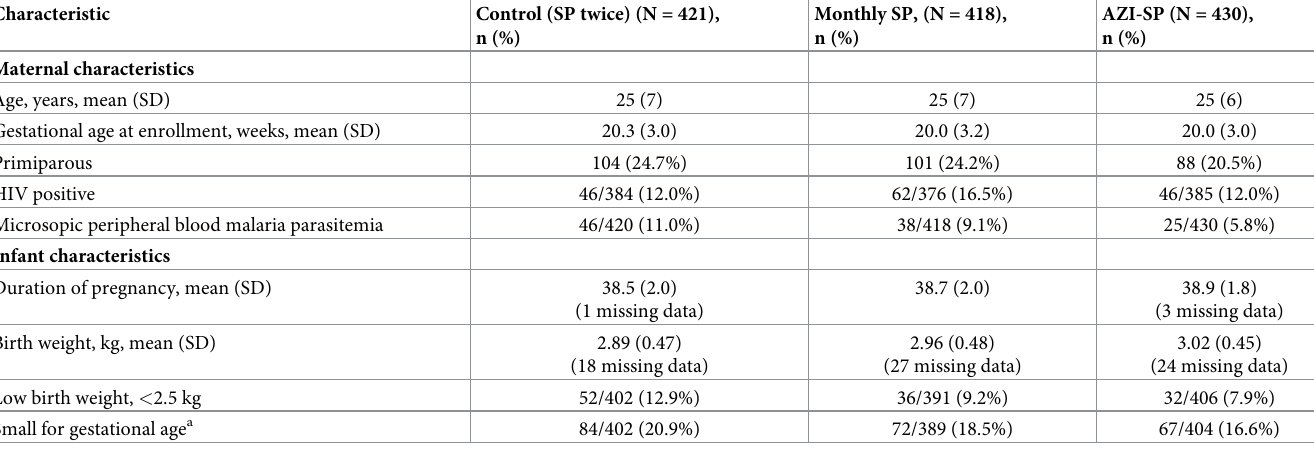
Table 1. Baseline characteristics of the participating women at enrollment and infant characteristics at birth for liveborn children, by study group.